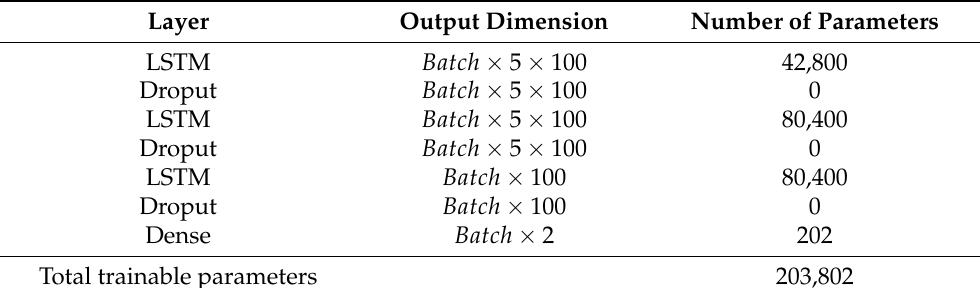
Table 2. LSTM model